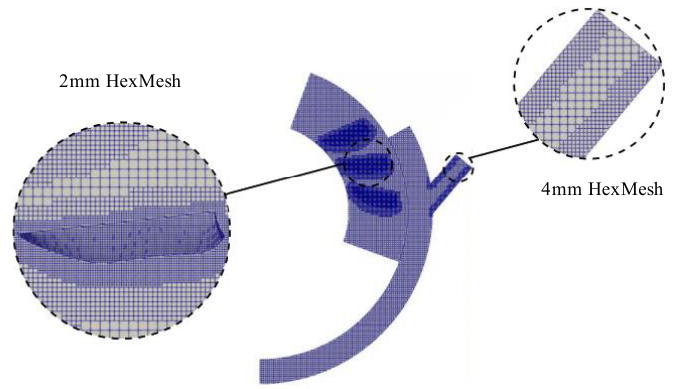
Figure 7. Discretization of computational fluid domain.